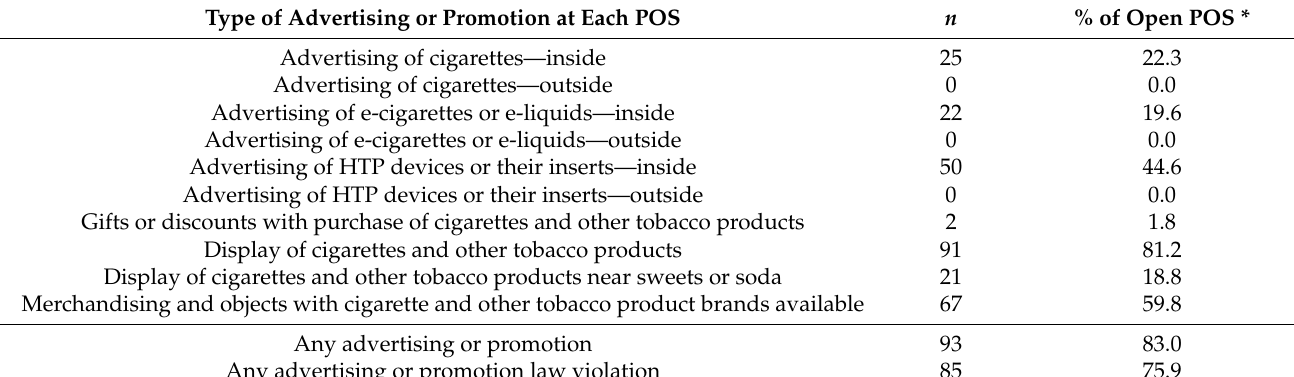
Table 2. POS with observed direct and indirect advertising by type of promotion.